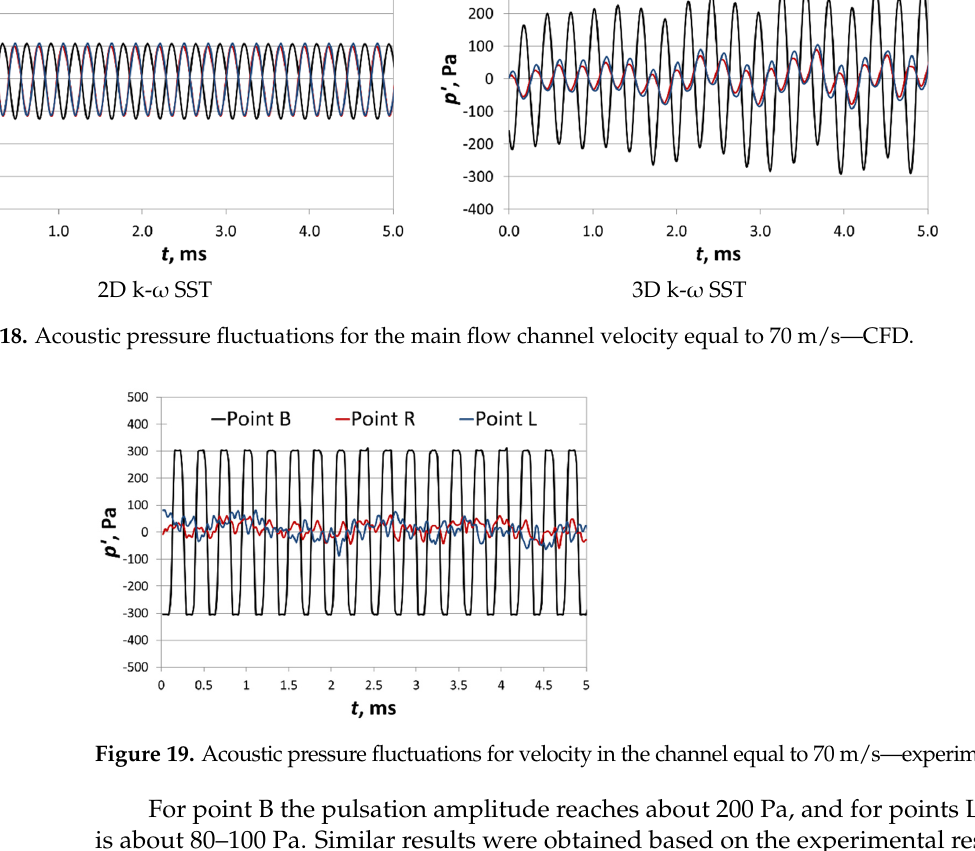
Figure 21. Spectral analysis of SPL for velocity equal to 70 m/s—experimental data. In this case, two well-marked harmonics were visible, but the component with a frequency of 1257 Hz and a sound pressure level of 110.6 dB was still dominant. Very good agreement was obtained in terms of the frequency and sound pressure levels between the experimental and numerical studies, including the applied two-dimensional CFD model. Figure 22 shows the spectral analysis of the sound pressure level for a flow velocity of 80 m/s, and Figure 23 presents the corresponding results of the experimental tests. 2D k- ω SST 3D k- ω SST Figure 22. Spectral analysis of SPL for velocity equal to 80 m/s—CFD.